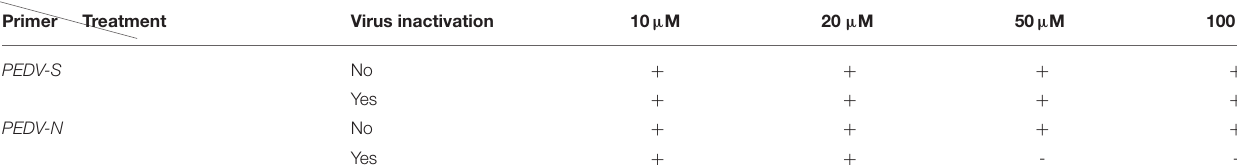
TABLE 3 | Two primers to determine the effectiveness of different PMA concentrations. Primer Treatment